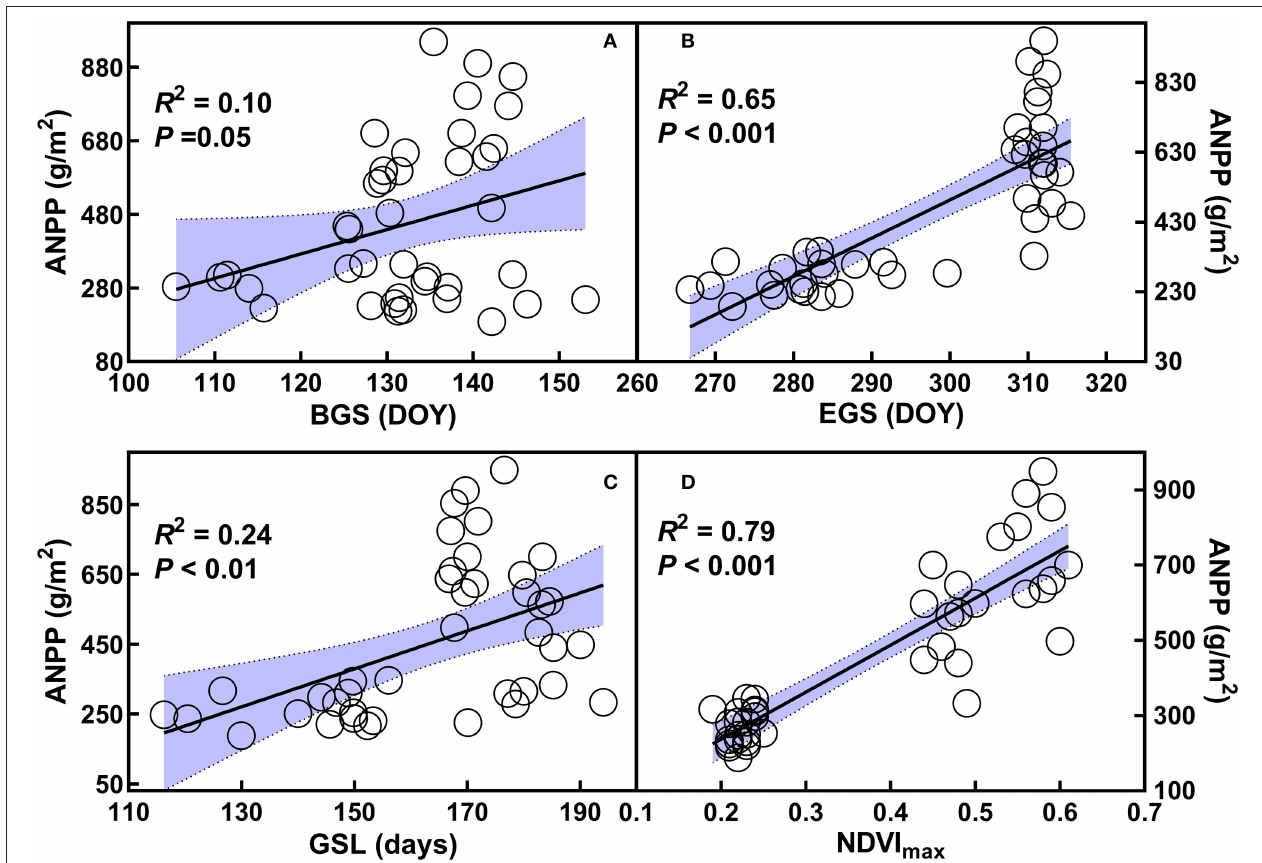
FIGURE 4 | Relationships of aboveground net primary productivity (ANPP) with beginning (A) , ending (B) , and length of growing season (C) , as well as the maximum of normalized difference vegetation index (D) over the two years from 2014 to 2015. Refer to abbreviations in Table 1 .